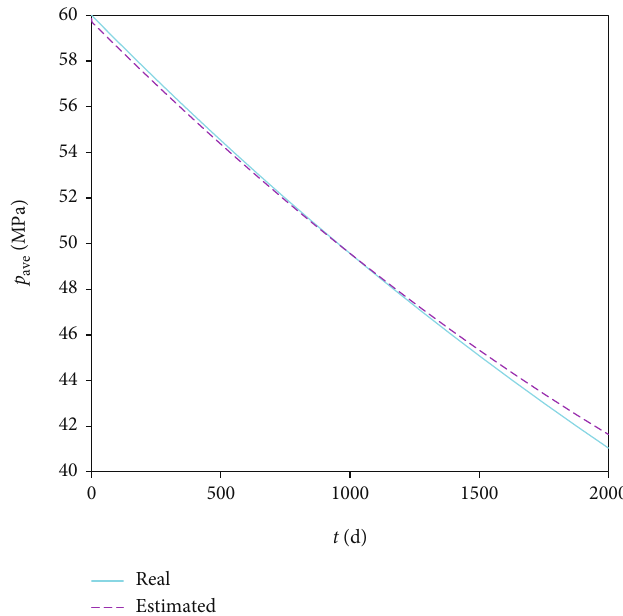
Figure 12: The real and estimated pro fi les of average reservoir pressure for the gas well producing at a constant production rate.